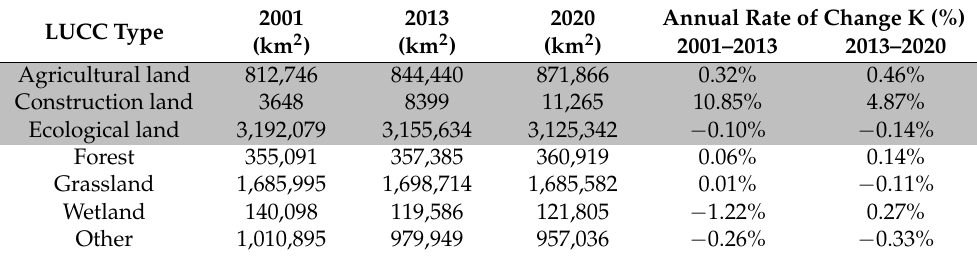
Table 6. Dynamic changes of LUCC in the CANs from 2001 to 2020 (km 2